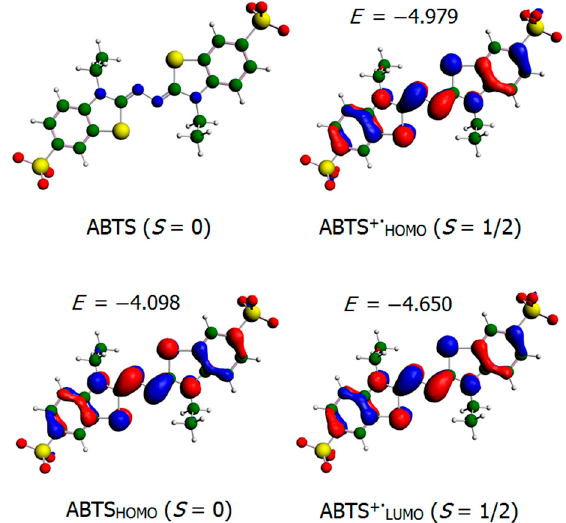
Figure 7. Optimized structure of singlet ABTS together with the three selected frontier orbitals (HOMO ABTS , HOMO ABTS + · and HOMO ABTS + · ). Energy values in eV. Parent ABTS and ABTS + · were assigned an overall charge of − 2 and − 1, respectively.